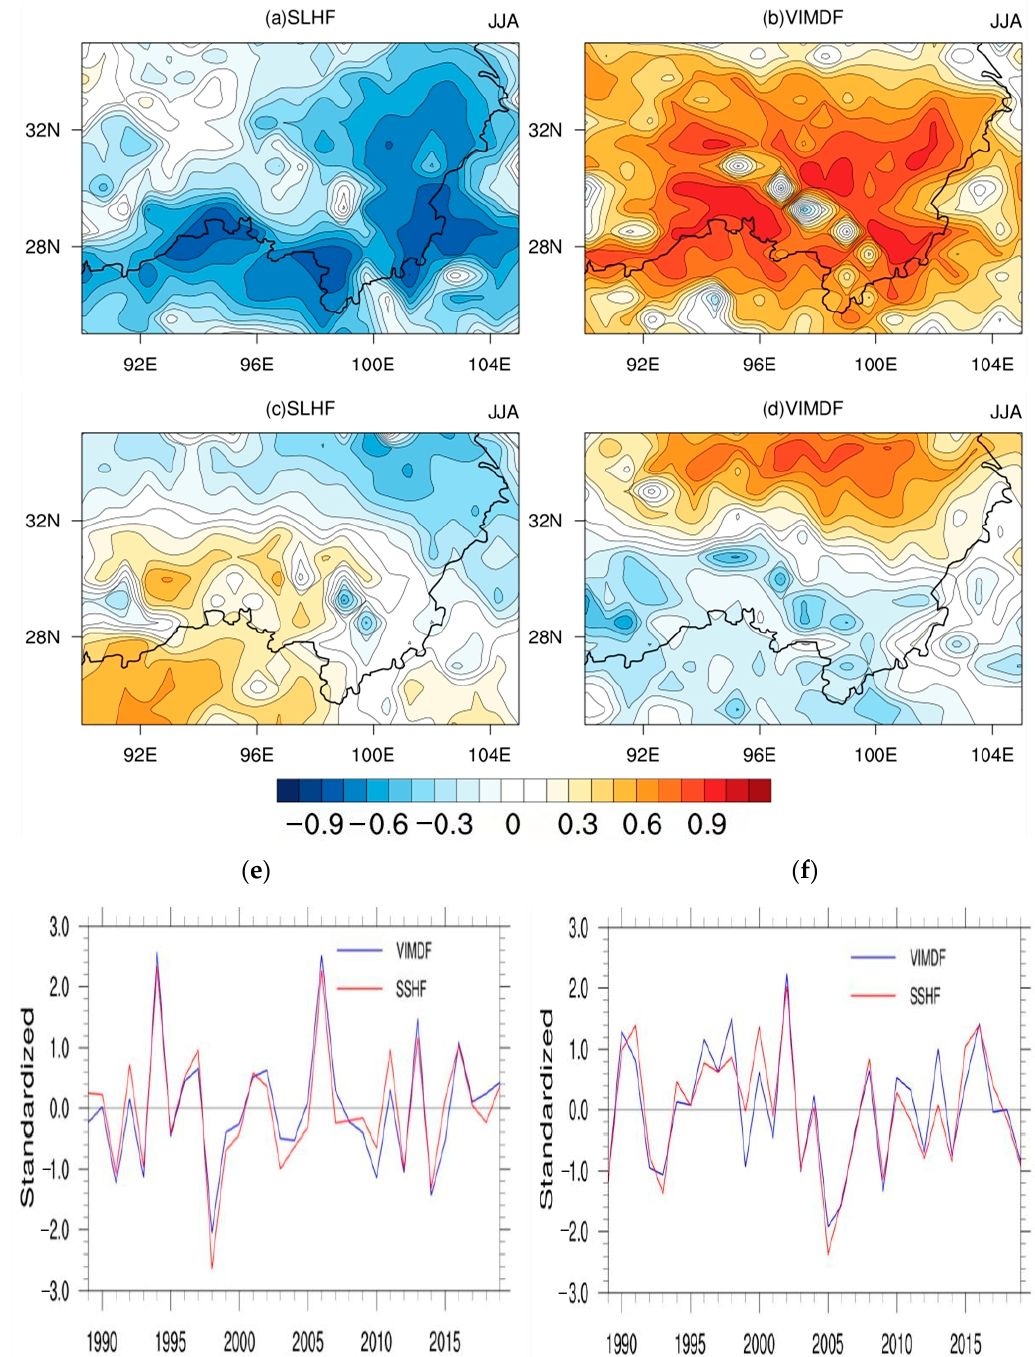
Figure 7. ( a – d ) SVD analysis and ( e , f ) corresponding time series of the latent heat field and the water vapor flux divergence field in southeastern Tibet in summer. ( a ) the first mode of the latent heat field; ( b ) the first mode of water vapor flux divergence field; ( c ) the second mode of the latent heat field; ( d ) the second mode of water vapor flux divergence field; ( e ) the first mode; and ( f ) the second mode. The solid black line is the boundary of the Tibetan Plateau in ( a – d ). The solid red line is SSHF time series and the solid blue line is VIMDF time series in ( e , f ).